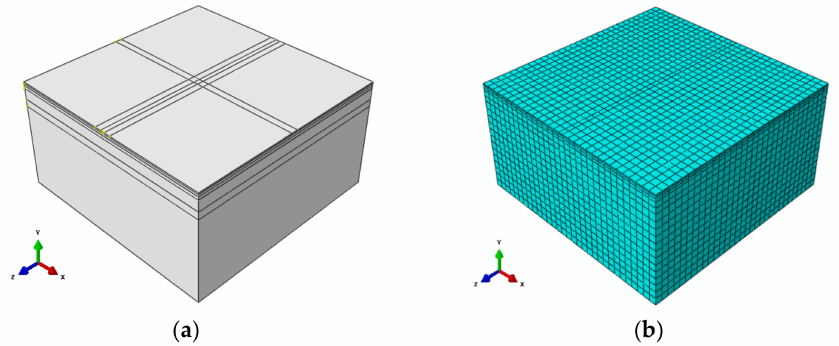
Figure 4. Asphalt pavement structure model ( a ) and grid division diagram ( b